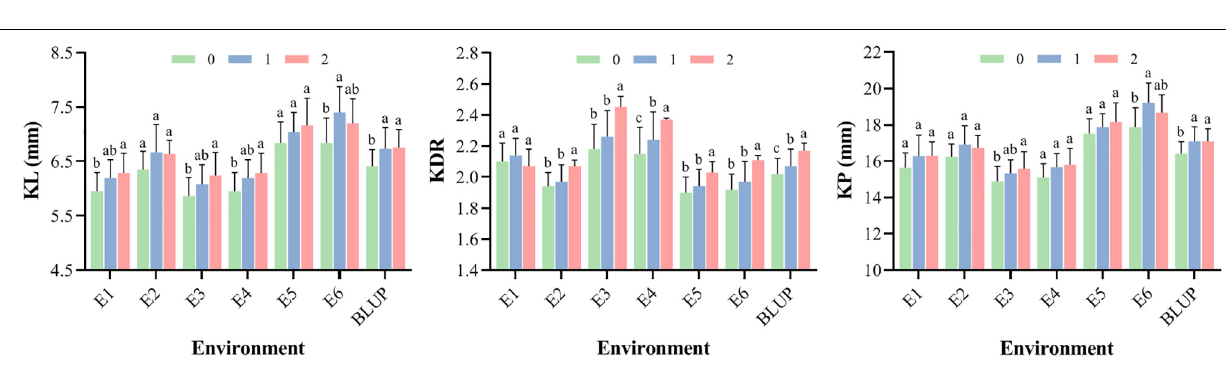
FIGURE 6 | The mean of KL, KDR, and KP for wheat accessions with 0–2 superior alleles in different environments. The different letters are significantly different at P < 0.05 according to Duncan’s multiple range